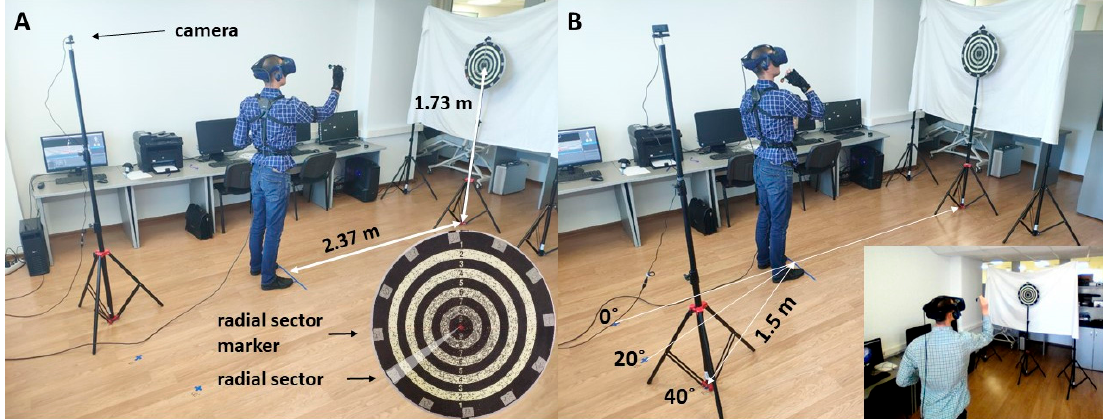
Figure 1. Method of the study. Subjects wore the motion capture suit and threw the darts from the first and the 3PPs. A . dartboard location relative to the subject, the insert shows the dartboard with the radial sector and radial sector marker. B . The relative to the subject location of the camera used to simulate perception from a 3PP. The insert shows the image taken from a virtual reality (VR) headset when the subject threw the darts in a third-person perspective with a camera placed at a 40° angle position.